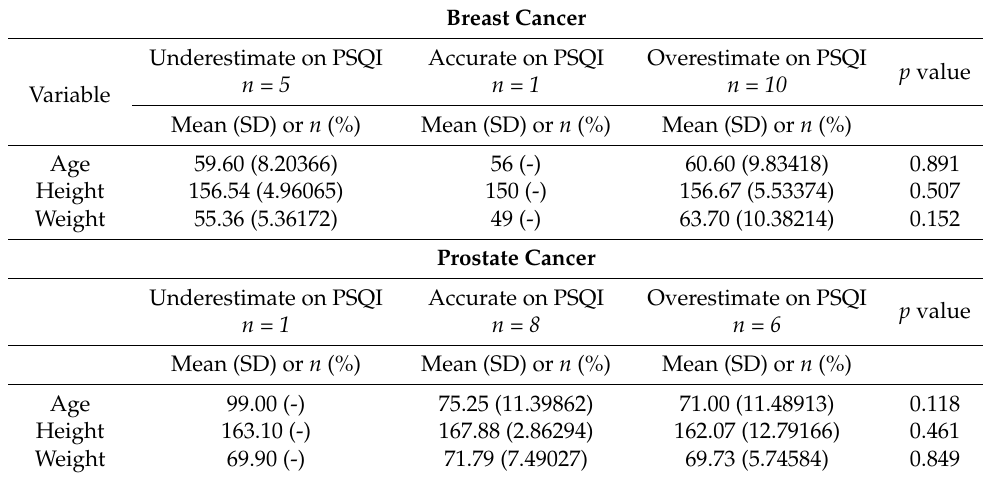
Table 5. Comparison of accurate and inaccurate self-reports on the PSQI on demographics in breast cancer and prostate